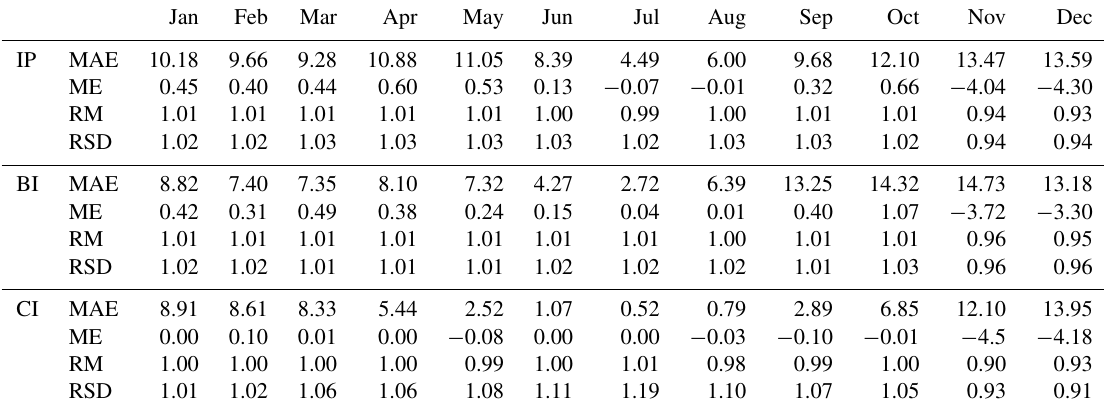
Table 5. The leave-one-out, cross-validation (LOO-CV) statistics, showing the goodness of fit between observations and estimates of monthly aggregates. IP: Iberian Peninsula; BI: Balearic Islands; CI: Canary Islands; MAE: mean absolute error; ME: mean error; RM: ratio of means; RSD: ratio of standard deviations. Results were constrained to 2 decimal places.